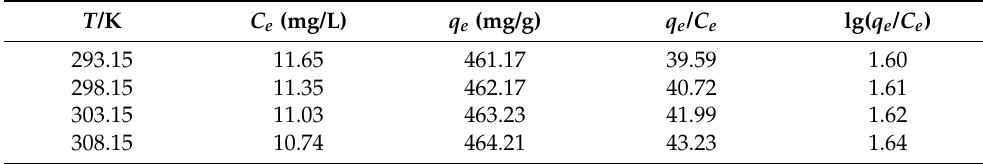
Figure 18. Relationship of lg( q e / C e ) and 1/ T. Table 6. Adsorption thermodynamic data of MCM-41.